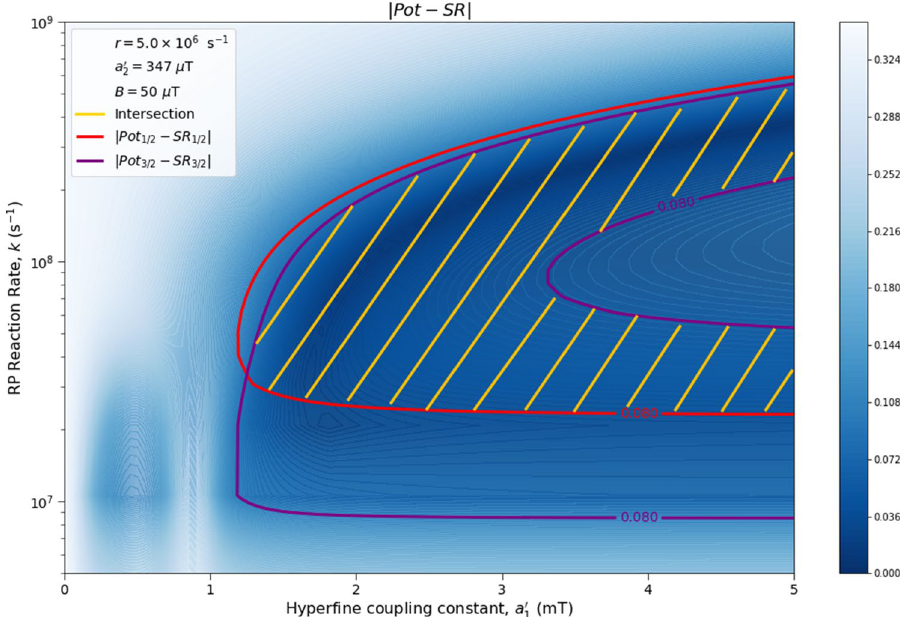
Figure 5. The dependence of the agreement between relative anesthetic potency and singlet yield ratio on changes in the hyperfine coupling constant a ′ 1 and the RP reaction rate k for a ′ 1 ∈ [ 0, 5000 ] µ T and k ∈ [ 5.0 × 10 5 , 1.0 × 10 9 ] s − 1 , using a ′ 347 µ T, B = 50 µ T, and r = 5.0 × 10 6 s − 1 . The singlet yield ratio 2 = SR is calculated using a 1 = (γ n / | γ 129 Xe | )γ e a ′ 1 , where the magnitude of the isotopic nuclear gyromagnetic correction factor, (γ n / | γ 129 Xe | ) , is normalized for 129 Xe. The model can explain the experimentally derived 6 relative anesthetic potency of xenon where ( | Pot 1 / 2 − SR 1 / 2 | ≤ 0.08 ) and ( | Pot 3 / 2 − SR 3 / 2 | ≤ 0.08 ) intersect, shaded in